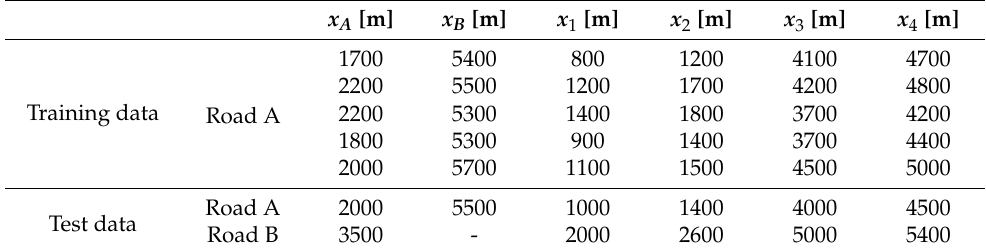
Table 2. The setting values of each road environment.